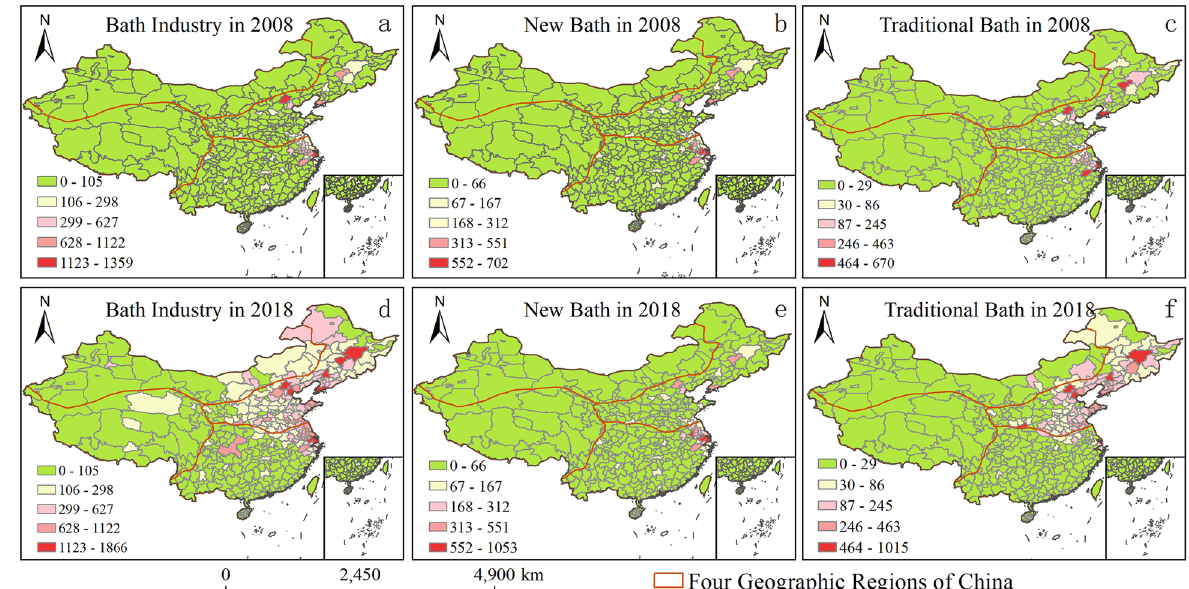
Fig. 2 Bath industry and its sub-categories spatial distribution